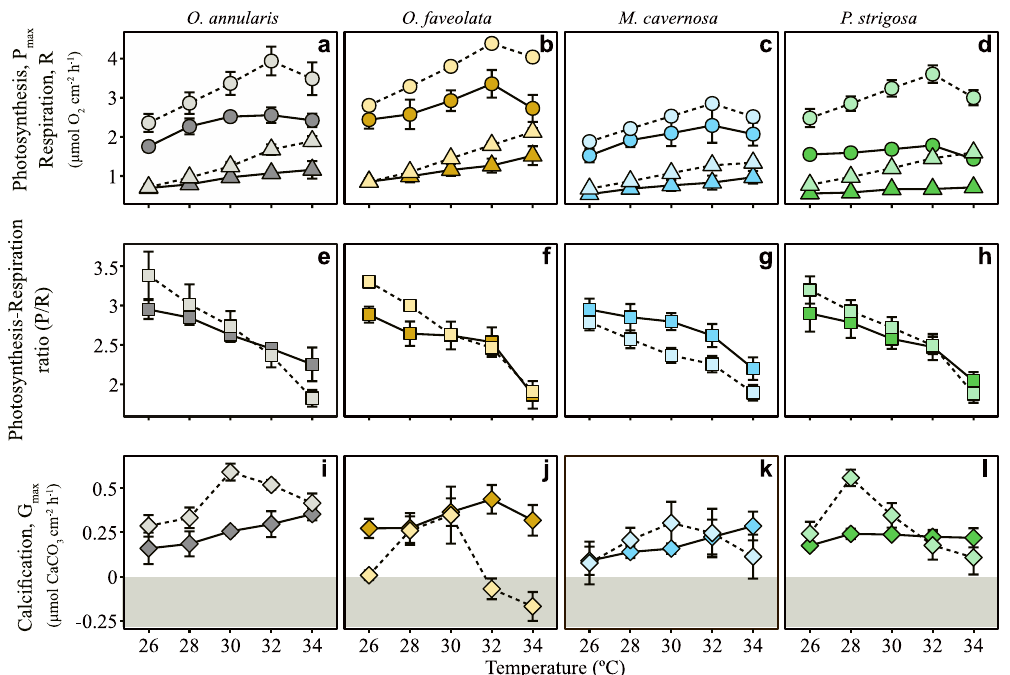
Figure 4. Scaling quotient of temperature (Q 10 ). Mean ± SE (n = 5) of the maximum gross photosynthesis rates (P max , circles), post-illumination respiration rates (triangles), P/R ratio (squares), and calcification rates (diamonds), for the winter (dark color) and summer (light color) phenotypes of Orbicella annularis (grey), Orbicella faveolata (orange), Montastraea cavernosa (blue), and Pseudodiploria strigosa (green). Negative values for coral calcification (grey area) are considered as indication of coral decalcification